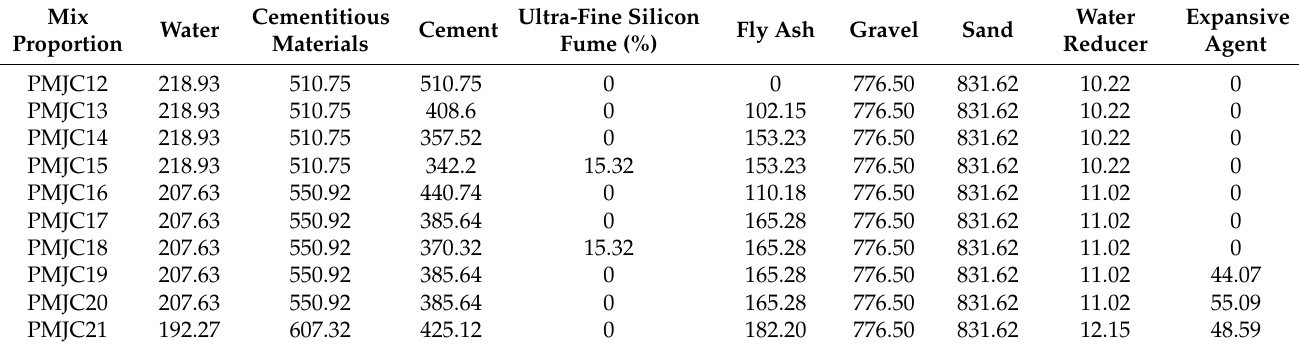
Table 11. The weight of raw materials per cubic meter of PMJC (unit: kg/m 3 ).